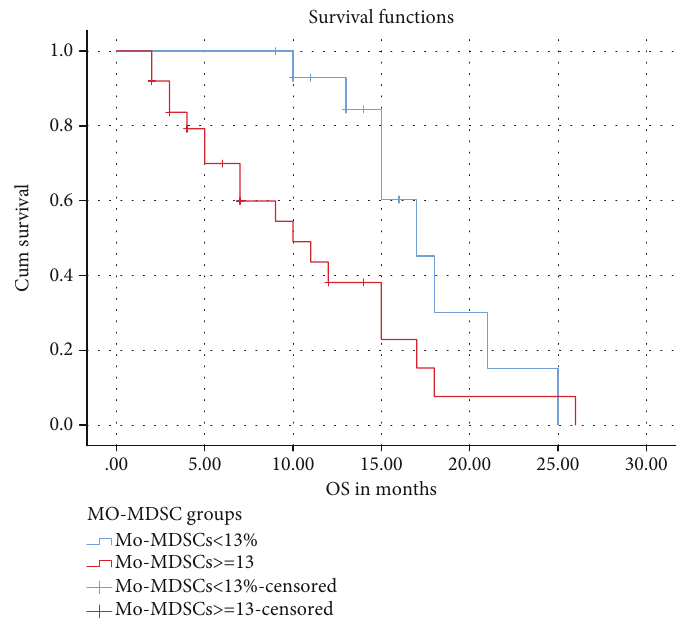
Figure 4: Di ff erences in overall survival (OS) according to myeloid-derived suppressor cell (Mo-MDSC) cuto ff value.